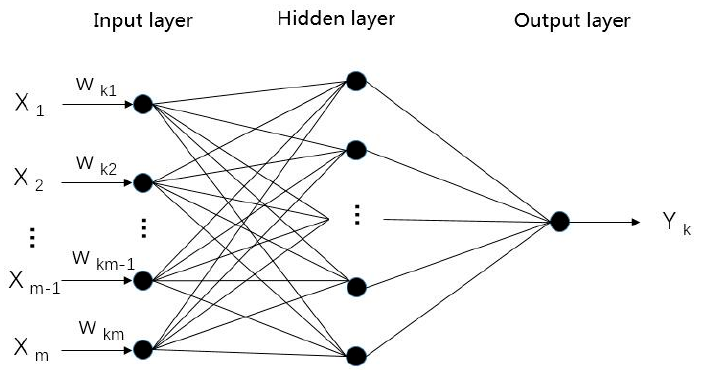
Figure 4. Artificial neural network (ANN) structure used in this study.